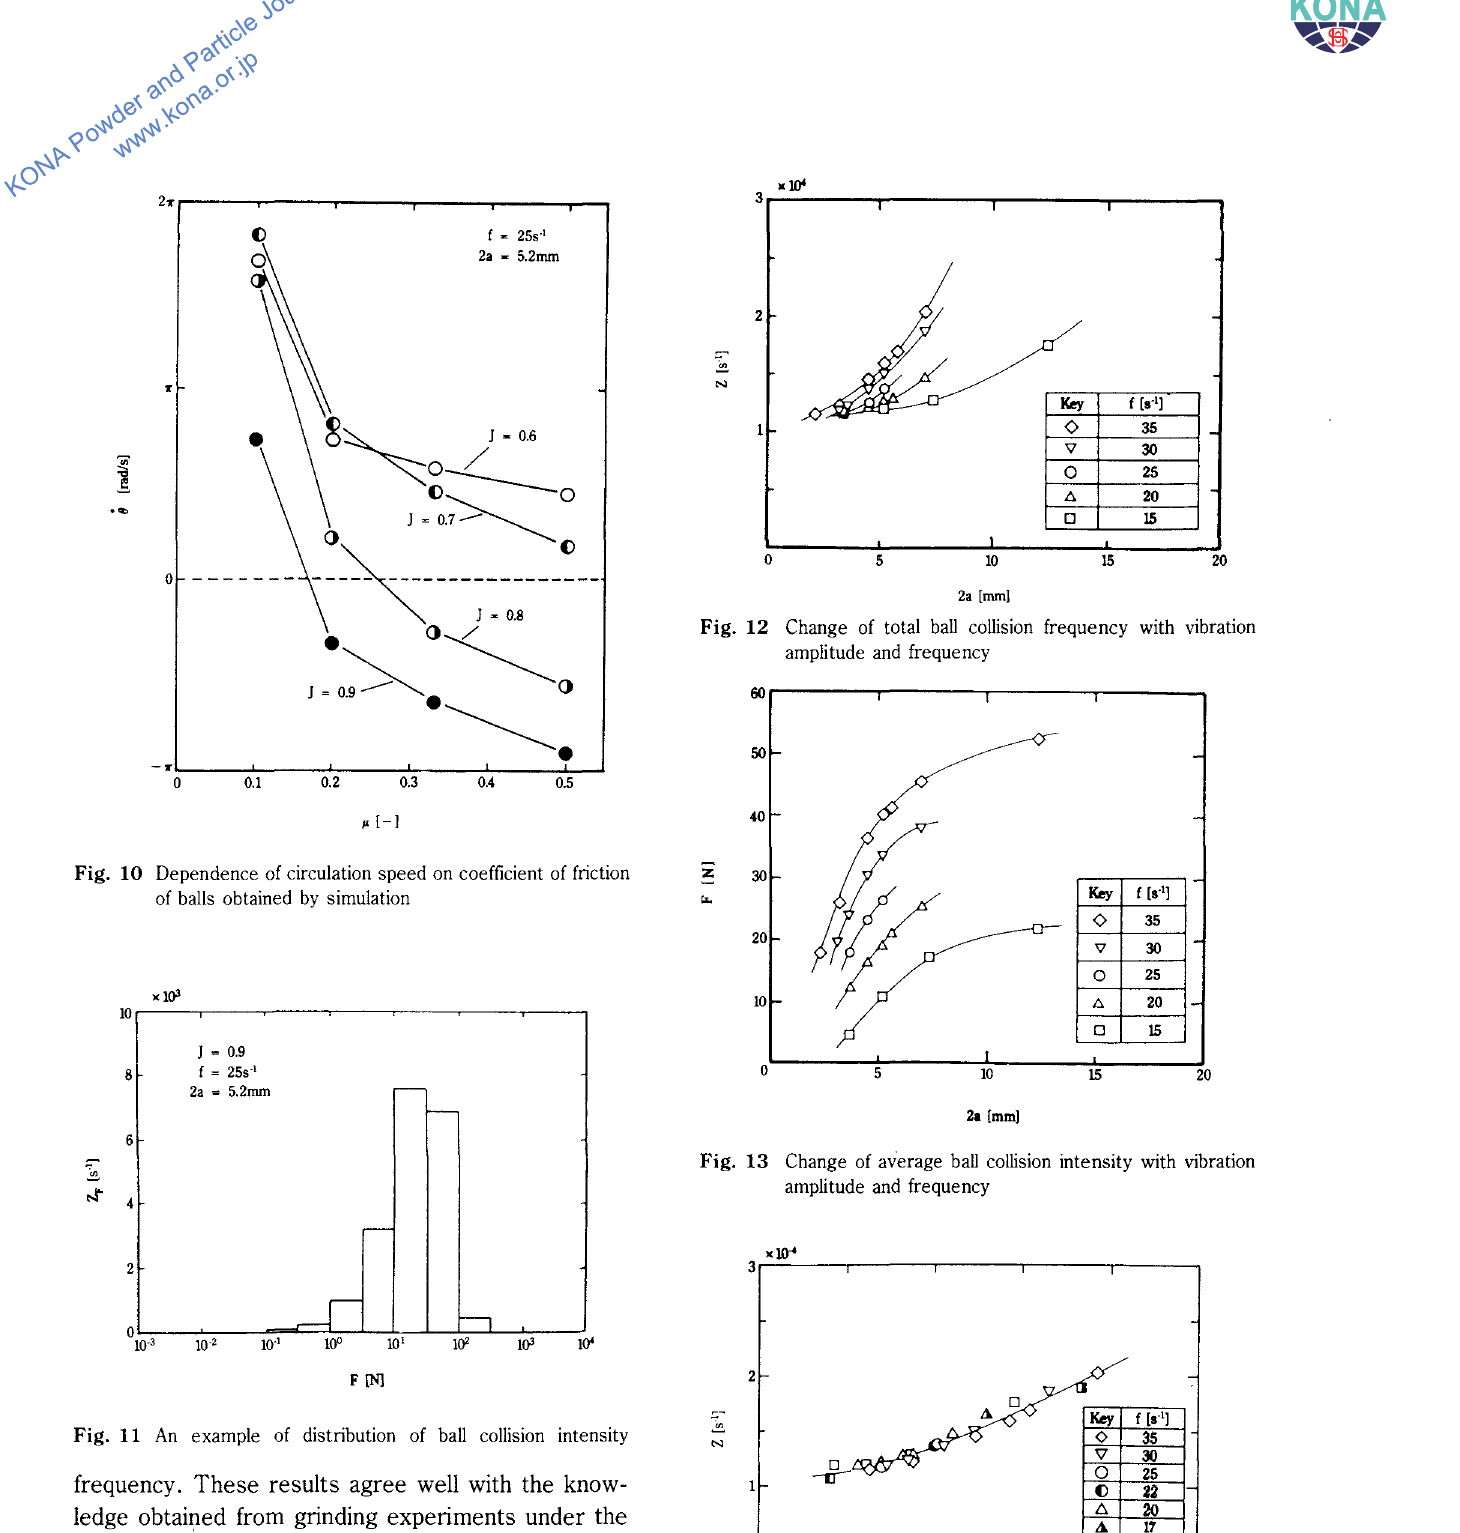
Fig. 13 Change of average ball collision intensity with vibration amplitude and frequency